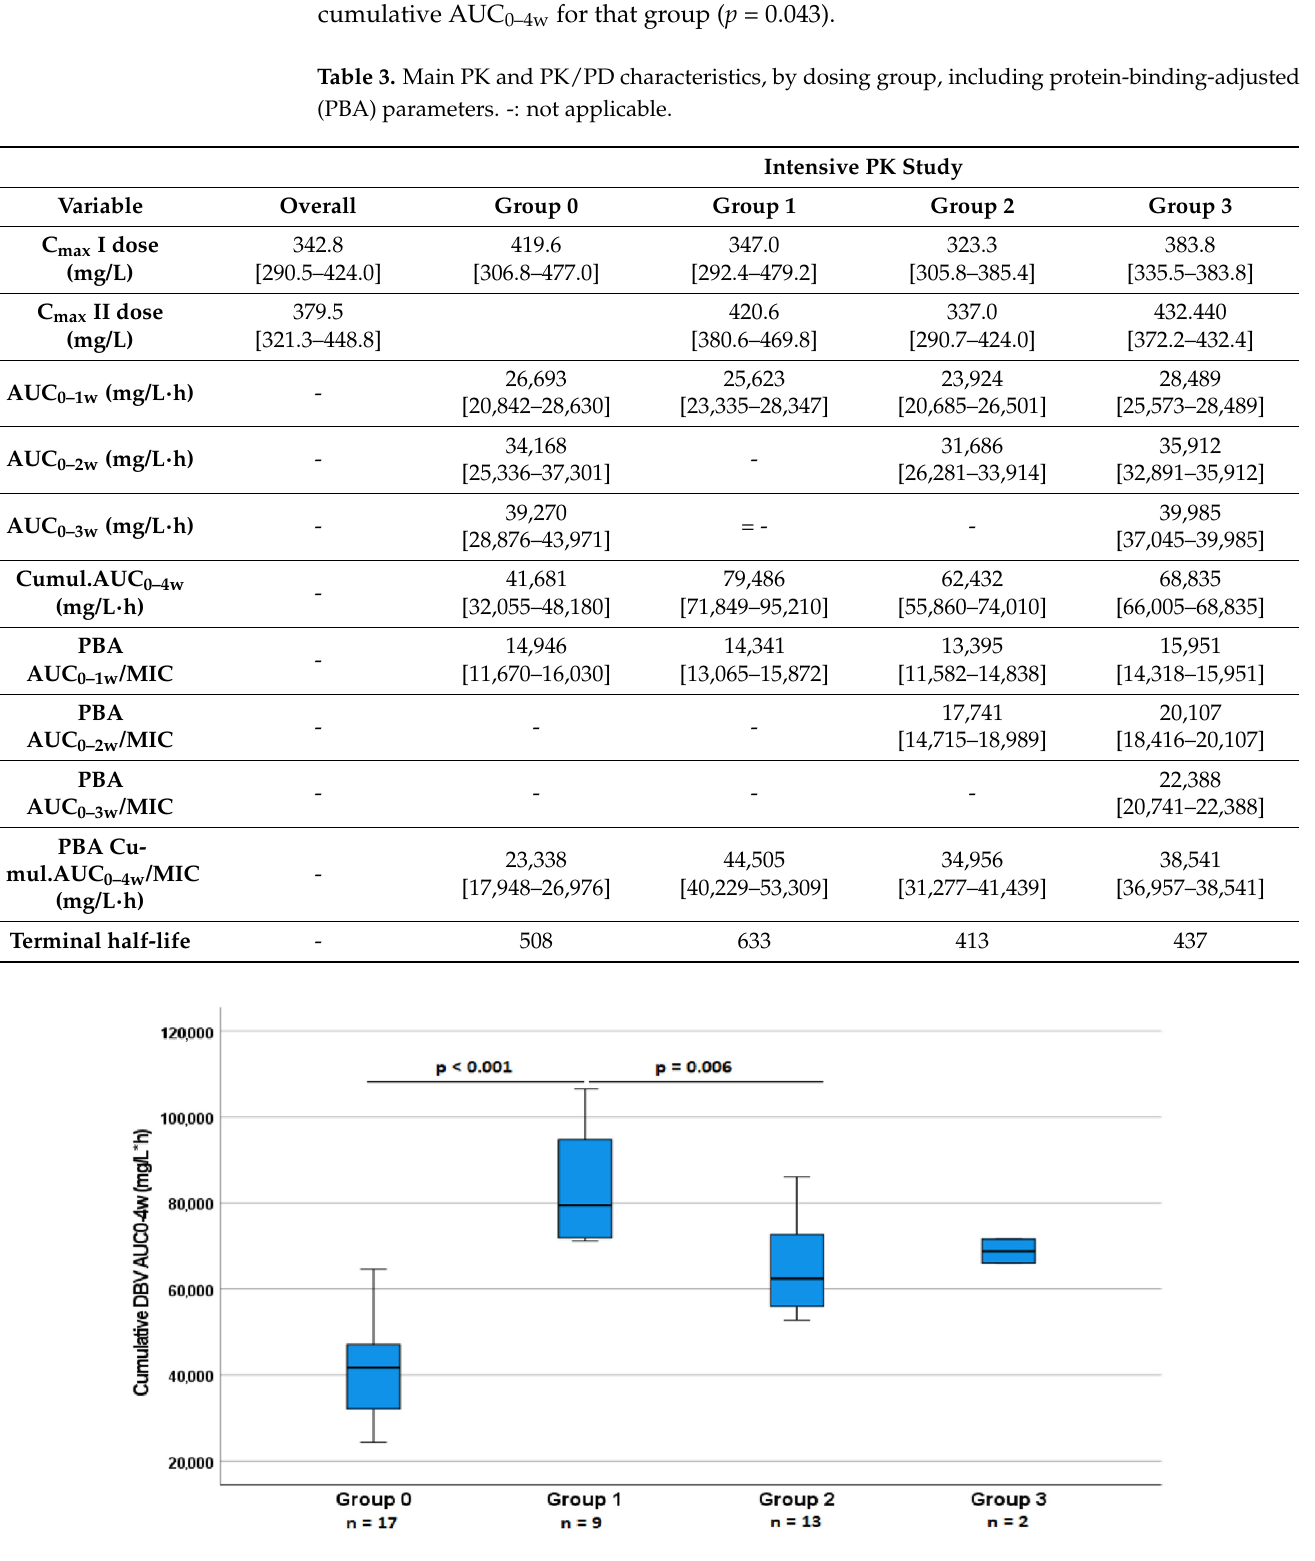
Table 3. Main PK and PK/PD characteristics, by dosing group, including protein-binding-adjusted (PBA) parameters. -: not applicable.